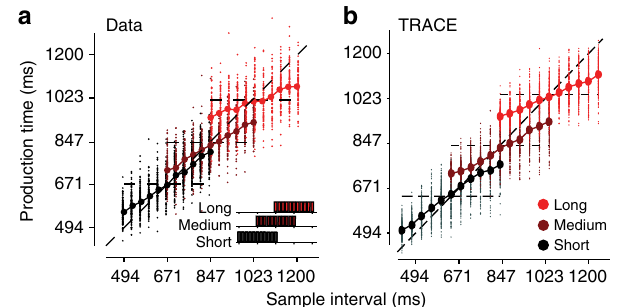
Fig. 4 Comparison of TRACE with human behavior in the RSG task. a Human behavior during the RSG task with three different prior distributions, Short (black), Medium (dark red) and Long (red). Data adapted from previous work 3 . Note that bias toward the mean of the prior is larger for longer interval ranges. b The corresponding prediction from TRACE. Dots and circles mark individual responses and averages respectively. To directly compare TRACE and human behavior, scalar noise was added to the output of TRACE to simulate responses (Methods section). Parameters of the model were not tuned to the data and a single-linear scaling factor was used to calibrate model output for all conditions